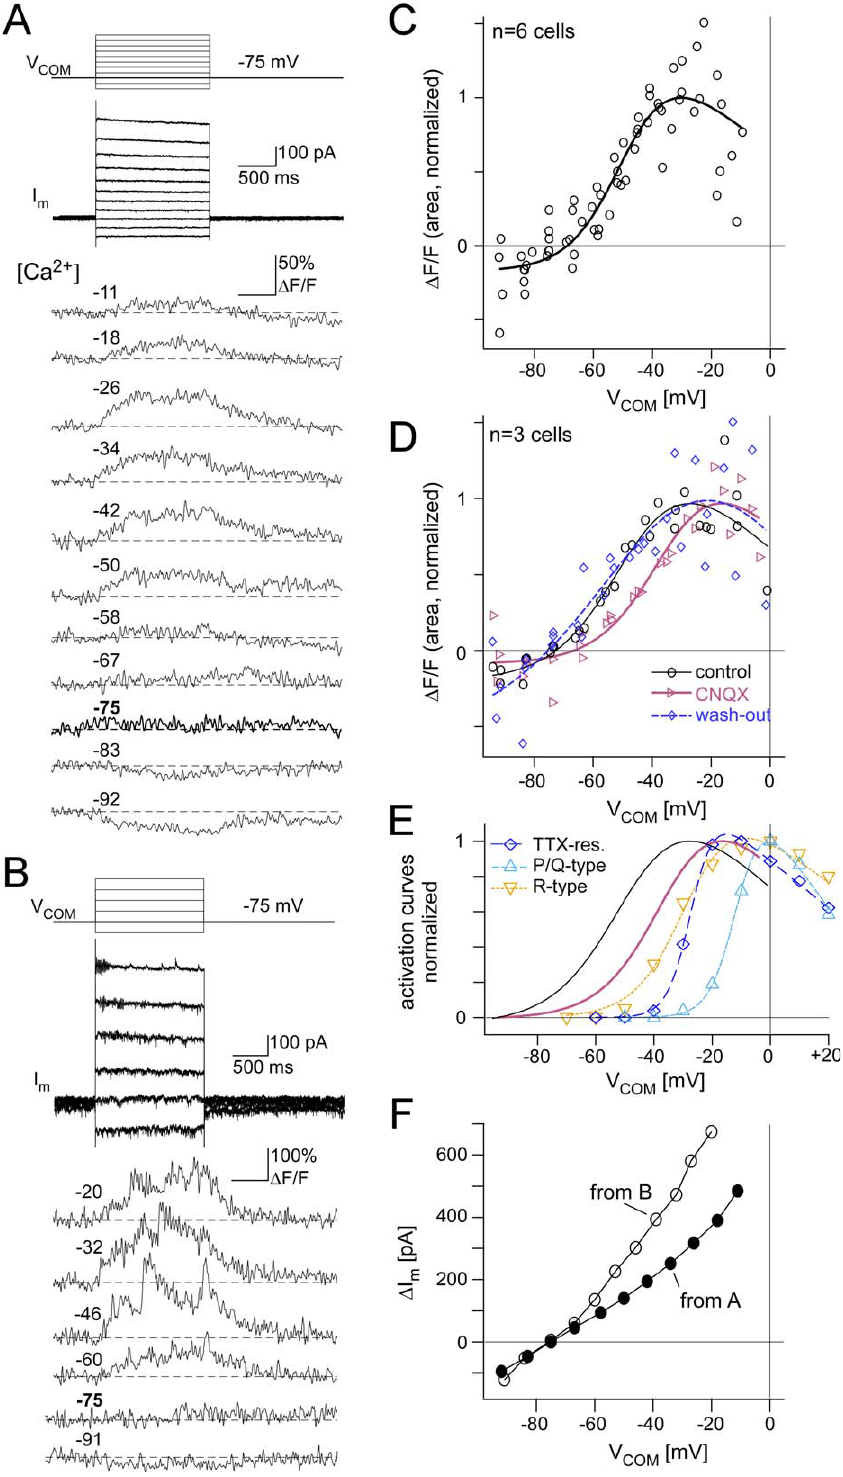
Figure 7. Voltage-Dependent Dendritic Ca 2 þ Signals (A) Somatic voltage step (from V COM ¼(cid:2) 75 mV) evoked changes in somatic current ( I m ) and dendritic [Ca 2 þ ] (single trials). Oregon-Green 488 BAPTA-1 (100 l M) signals ( D F/F in percentages) recorded by two-photon imaging; Cs þ -based intracellular solution. (B) Example of spiky [Ca 2 þ ] transients riding on smooth responses (different cell but same protocol as in [A], single trials; some traces omitted). (C) Ca 2 þ responses (circles) as a function of V COM for cells lacking spiky activity; each symbol represents a single response; for each cell, amplitudes were normalized to the response-amplitude at (cid:2) 35 mV (see Materials and Methods); continuous line: fitted activation curve (using Equation 5). (D) [Ca 2 þ ] versus voltage data before (control; black) during (purple) and after (washout; blue) bath application of CNQX (10 l M). (E) Curve fits from C and D overlaid with fits (Equation 5) to data from the literature for P/Q-type (cyan upward triangles, g ¼(cid:2) 0.023 6 0.001; V 50 ¼(cid:2) 10.9 6 0.5 mV; V Slope ¼ 4.56 6 0.35; E Ca ¼ 46.8 6 1.2 mV; [45] and R-type (orange downward triangles, g ¼(cid:2) 0.013 6 0.003; V 50 ¼(cid:2) 27.5 6 2.1 mV; V Slope ¼ PLoS Biology |